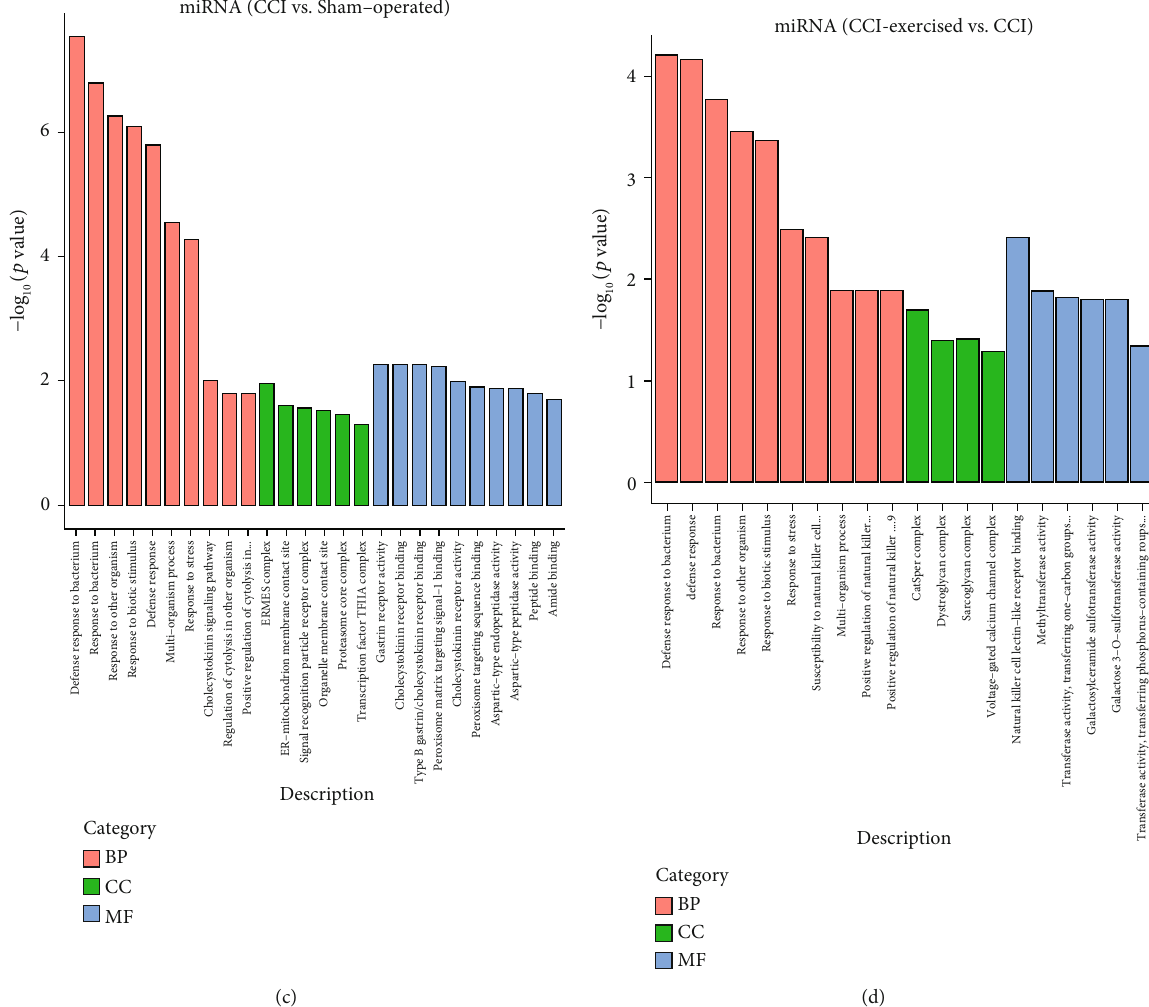
Figure 7: Gene Ontology (GO) analysis of di ff erentially expressed genes (DRGs). The top 10 high-enrichment score terms of di ff erentially expressed microRNAs (miRNAs) are shown in the histography (a) between the sham-operated group and the chronic constrictive injury (CCI) group and (b) between the CCI group and the CCI-exercised group. The top 10 high-enrichment score terms of di ff erentially expressed mRNAs are shown in the histography (c) between the sham-operated group and the CCI group and (d) between the CCI group and the CCI-exercised group ( n = 3 animals per